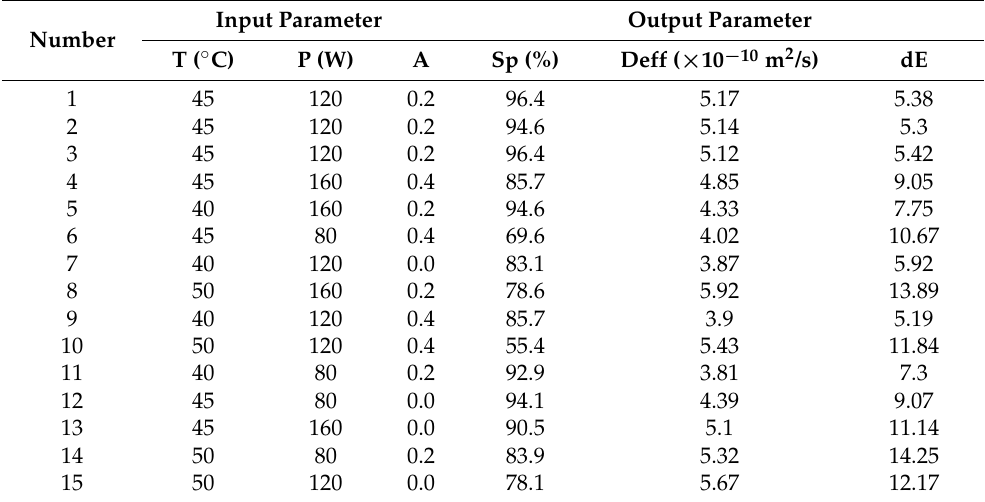
Table 1. Experimental matrix and